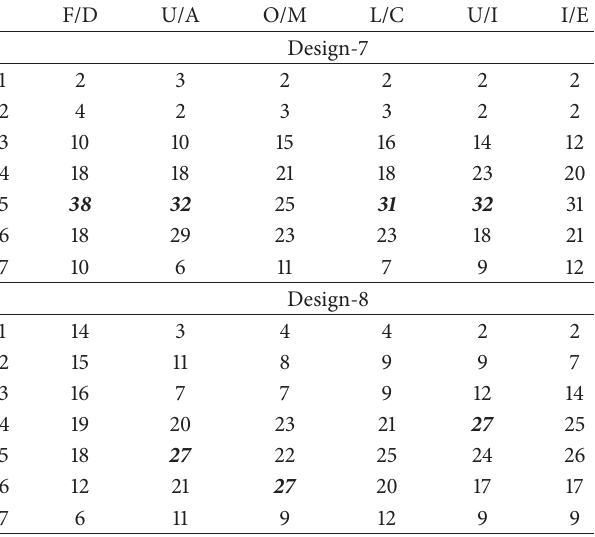
Table 4: The respondents’ answers to the designs proposed.